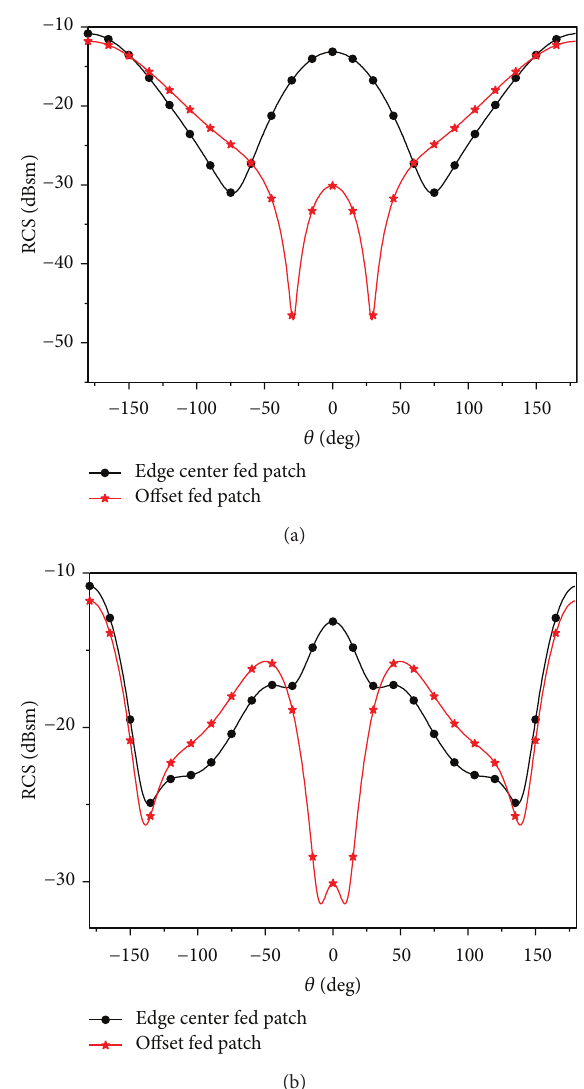
Figure 6: Bistatic in-band RCS of the edge center fed antenna ( 𝑓 = 4.319 GHz) and offset fed antenna ( 𝑓 = 4.163 GHz) for a normal incident plane wave: (a) yoz -plane (E-plane) and (b) xoz -plane (H-